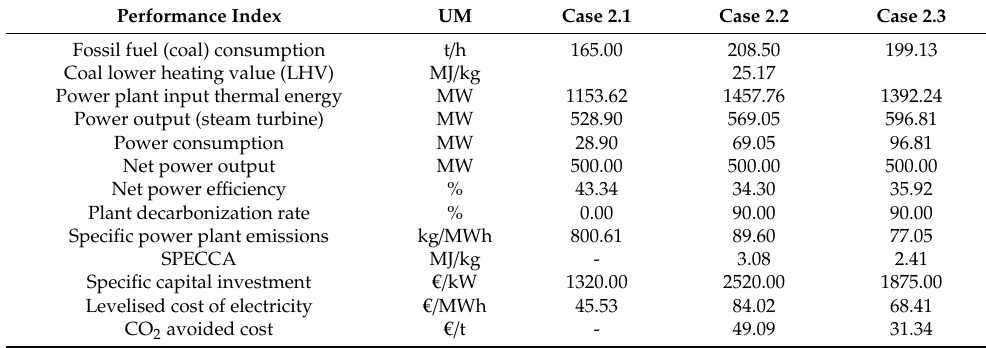
Table 3. Super-critical power plants techno-economic and environmental performance indexes.